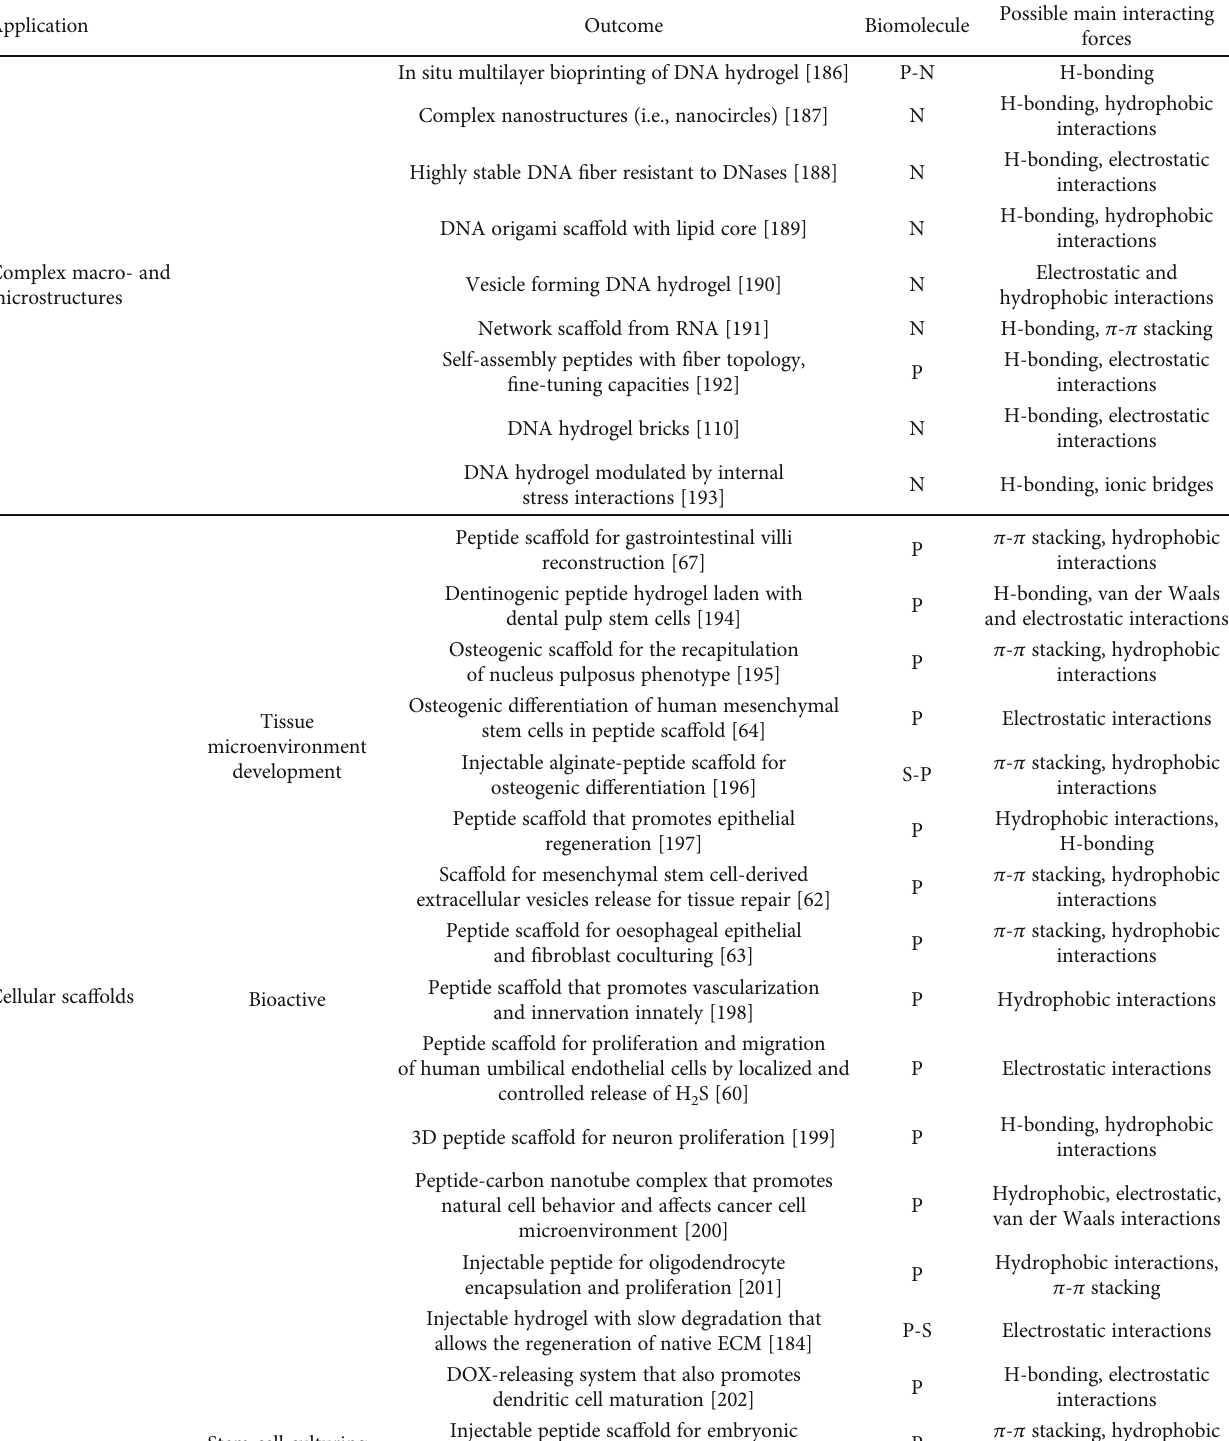
Table 1: Engineered SBPs developed in the last 15 years arranged by applications on TE and regenerative medicine.